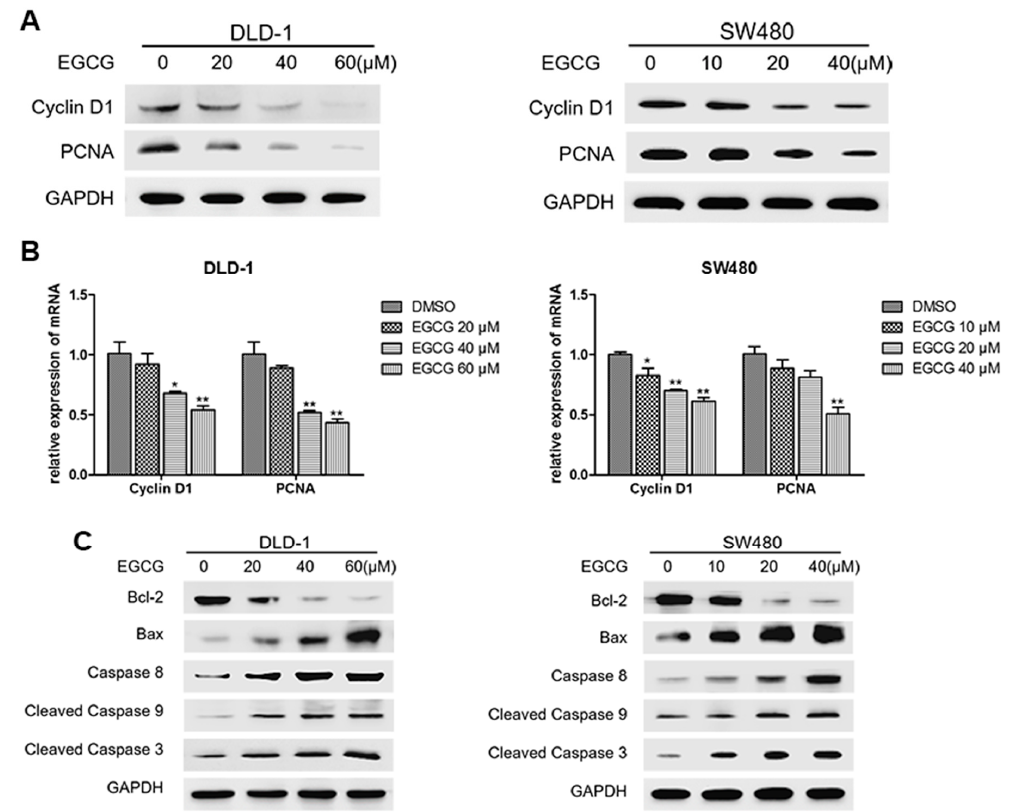
Figure 4. EGCG reduced cell proliferation and induced apoptosis of colorectal CSCs. DLD-1 and SW480 spheroids were treated with different concentrations of EGCG for six days. ( A ) Protein expression levels of PCNA and Cyclin D1 were measured by Western blot analysis; ( B ) Quantitative real-time PCR analysis for the detection of mRNA levels of PCNA and Cyclin D1; ( C ) Expression levels of apoptosis related proteins, including Bcl-2, Bax, Caspase 8, Cleaved Caspase 9, and Cleaved Caspase 3, were measured by Western blot analysis. Data are expressed as mean ± SD of three independent experiments. * p < 0.05, ** p < 0.01 compared with control group.